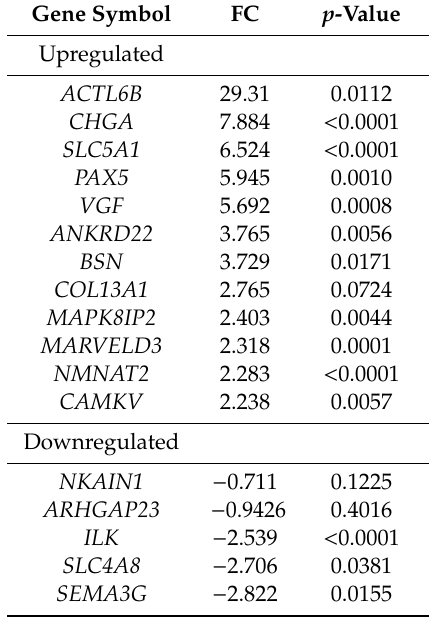
Table 7. Validation of target genes by qRT-PCR analysis in ILK-siRNA(2) vs. C-siRNA. Gene Symbol